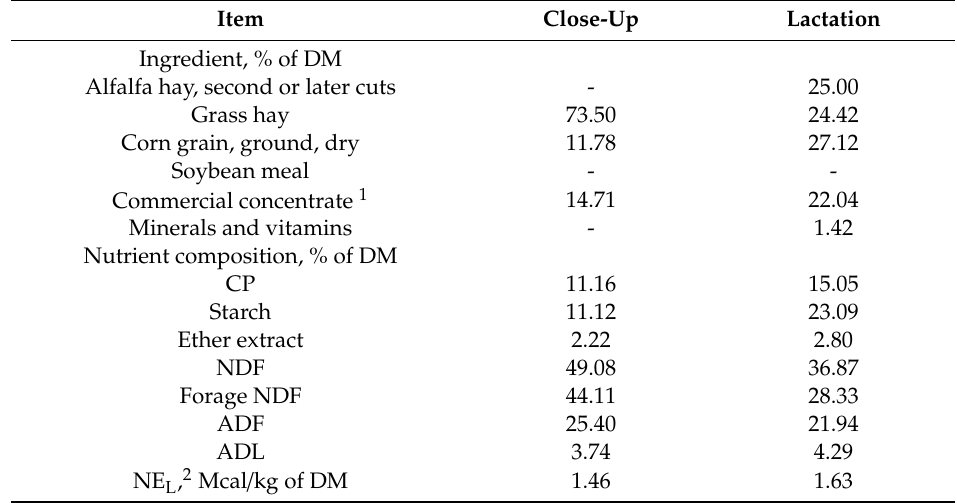
Table 1. Ingredient and nutrient composition of close-up (from − 21 to parturition) and early lactation (from parturition to 30 DIM) diets for Simmental dairy cows treated with pegbovigrastim (PEG) or with saline (CTR) at approximately d − 7 relative to calving and on the day of calving within 6 h. Item Close-Up Lactation Ingredient, % of DM Alfalfa hay, second or later cuts - 25.00 Grass